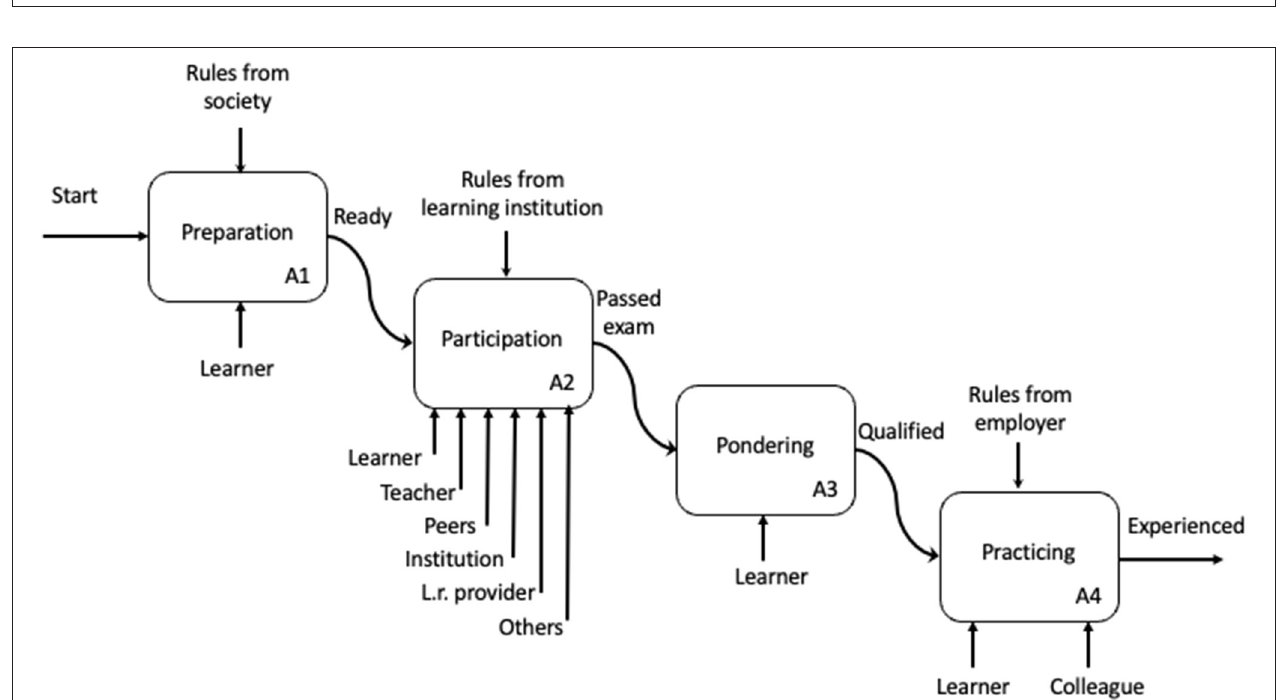
FIGURE 1 | Objective hierarchy during learning.